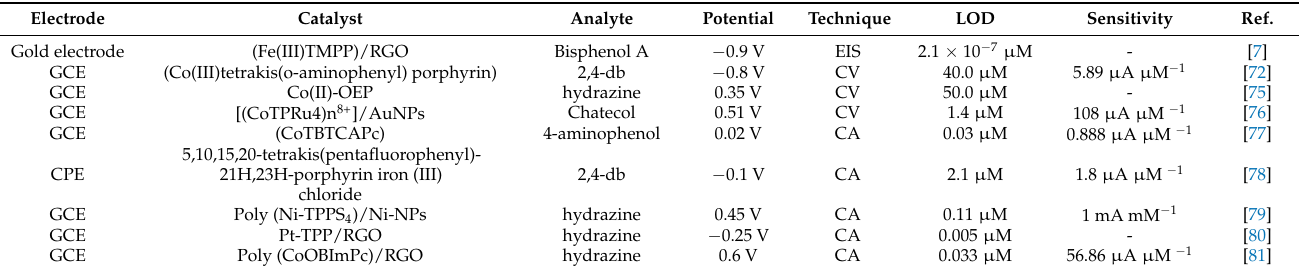
Table 8. Examples of electrochemical sensors based on MP and MPc complexes for organic pollutants sensing. Electrode Catalyst Analyte Potential Technique LOD Sensitivity